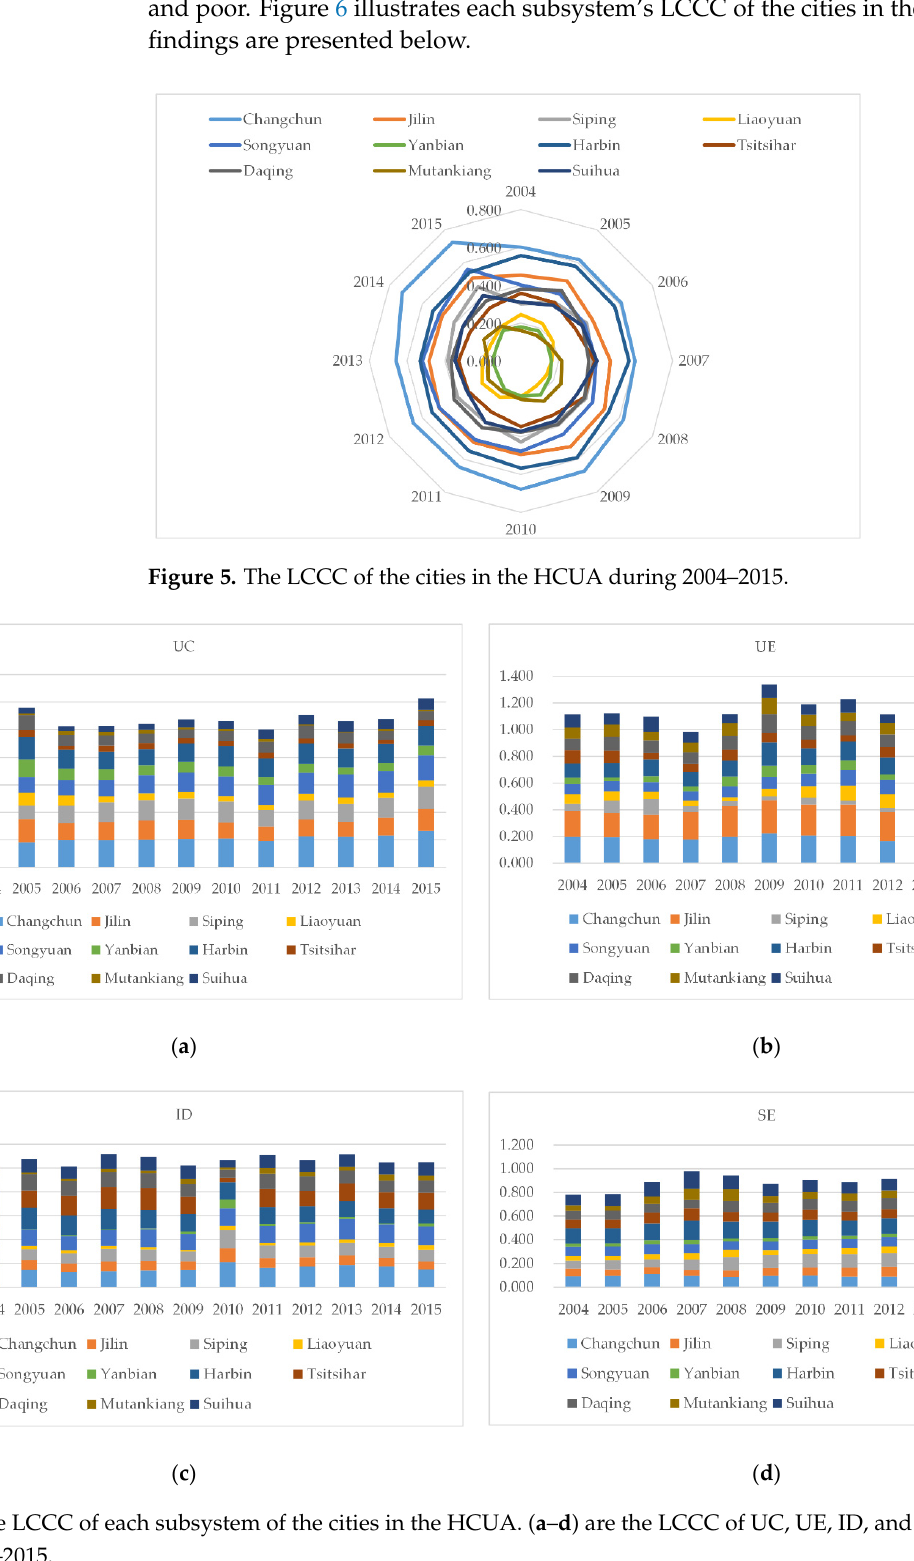
Figure 4. The four subsystems of the LCCC in the HCUA during 2004–2015.